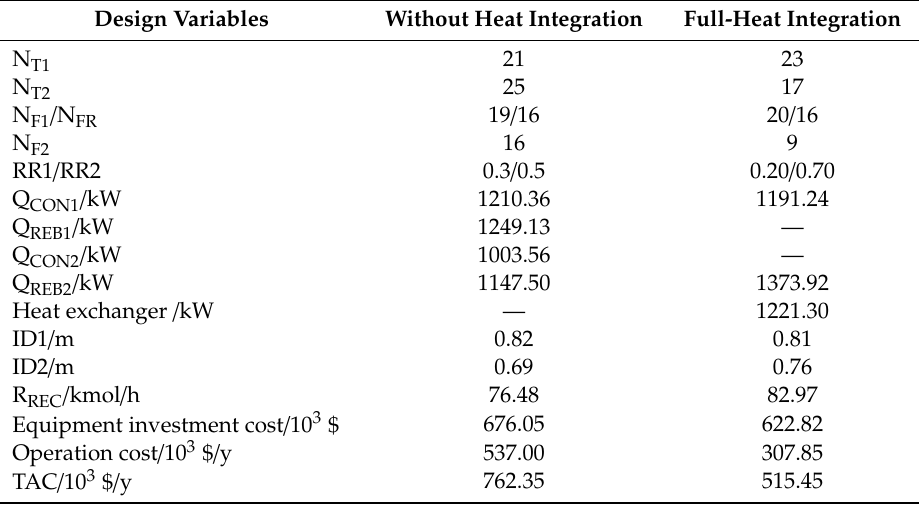
Table 4. Comparison of two technological